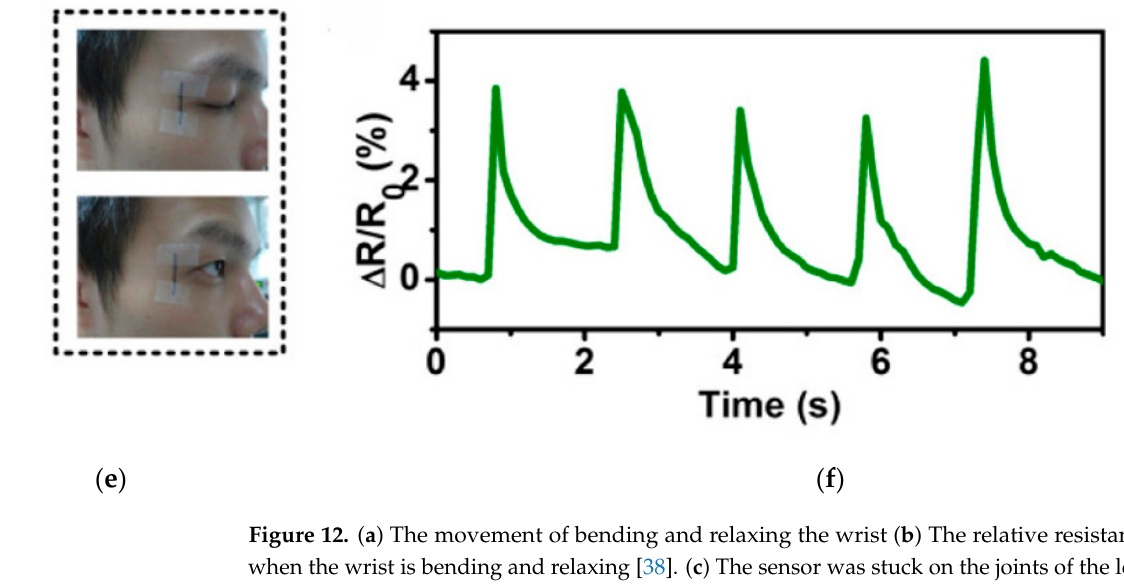
Figure 12. ( a ) The movement of bending and relaxing the wrist ( b ) The relative resistance change when the wrist is bending and relaxing [38]. ( c ) The sensor was stuck on the joints of the lower limbs with tape to monitor the squatting posture ( d ) The typical raw data obtained by the fiber-based sensor when detecting the squat and the noise is caused by the natural vibration of the limbs [88]. ( e ) Optical images of open eyes (bottom) and closed eyes (top). ( f ) The relative resistance change of the sensor showing the movement of small muscles caused by blinking [74].